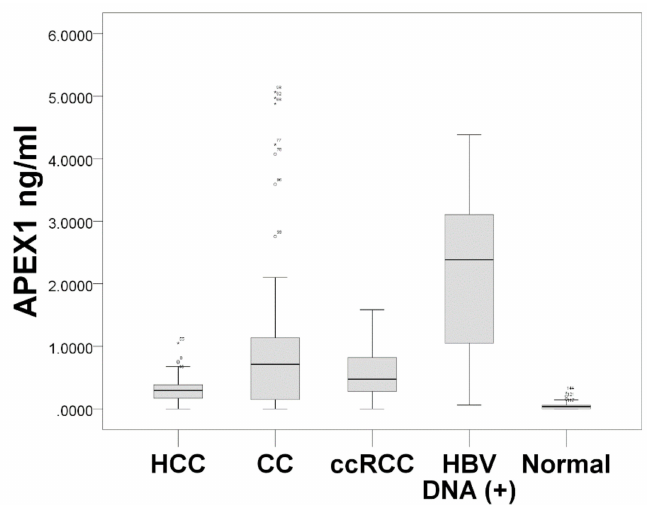
Figure 3. Comparison of the s-APEX1 levels among hepatocellular carcinoma (HCC), cholangiocarcinoma (CC), clear cell renal cell carcinoma (ccRCC), HBV DNA ( + ) (HBV DNA ≥ 58 copies / mL), and heathy control groups (Kruskal–Wallis test: p < 0.001). The dark line in the middle of the boxes is the median. The box length indicates the interquartile range. The ends of the whiskers represent maximum and minimum values.